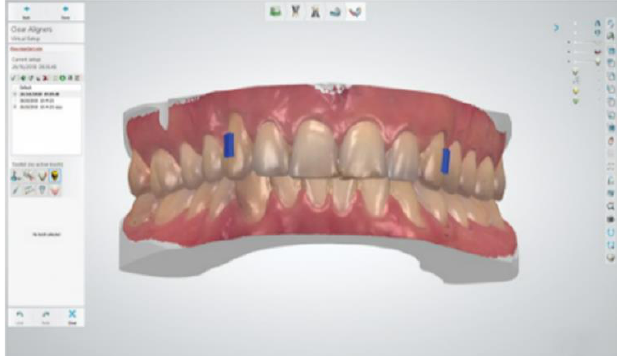
Figure 2. A 3Shape software used in this example to design a maxillary clear aligner.